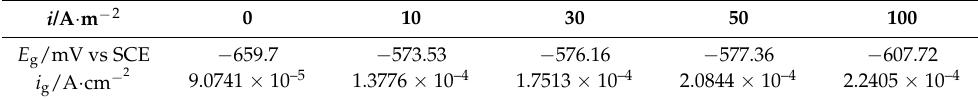
Table 4. Fitted results of potentiodynamic polarization curve for steel–copper with AC